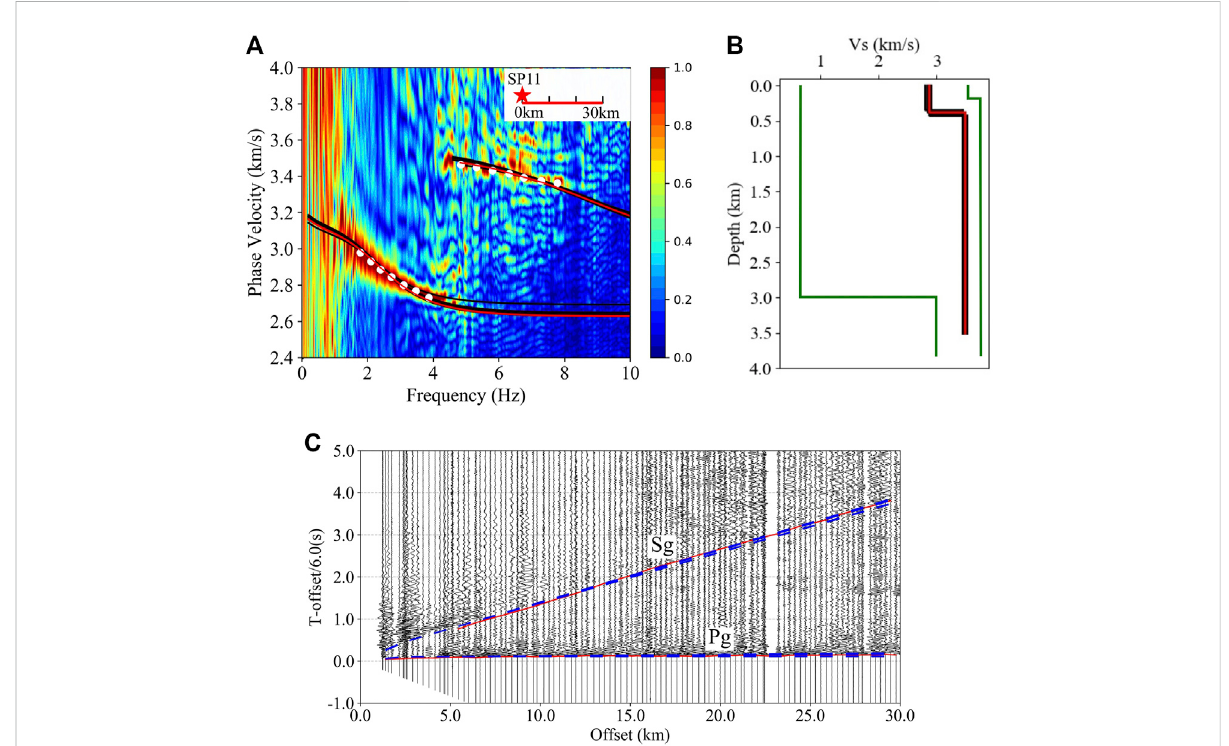
FIGURE 6 The results of the joint Monte Carlo inversion with the multimodal dispersion curves and the Pg and Sg travel times from the SP11 seismic data. (A) The black lines are the calculated dispersion curves of the accepted models, the red lines are the calculated dispersion curves of the best fi tting model, and the white dots are the picked dispersion curves. In the upper right corner, the red star represents the source, and the F-J spectrogram is extracted fromtheseismicdata on thered line. (B) The black linesare theaccepted models, and thered lineis thebest fi tting model. The green lines are the boundaries of the model parameters, and 10 6 initial two-layer models were randomly generated between the green lines. (C) The red lines are the picked Pg and Sg, and the blue dashed lines are the calculated Pg and Sg of the accepted models.